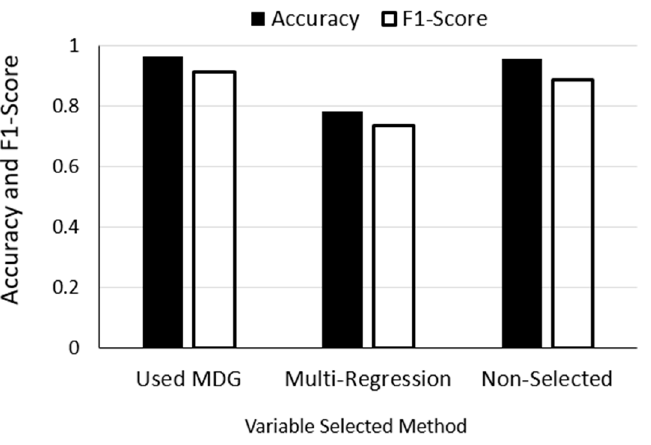
Figure 8. Results of performance comparison between the Mean Decrease Gini coefficients-based model and the non-Gini model.